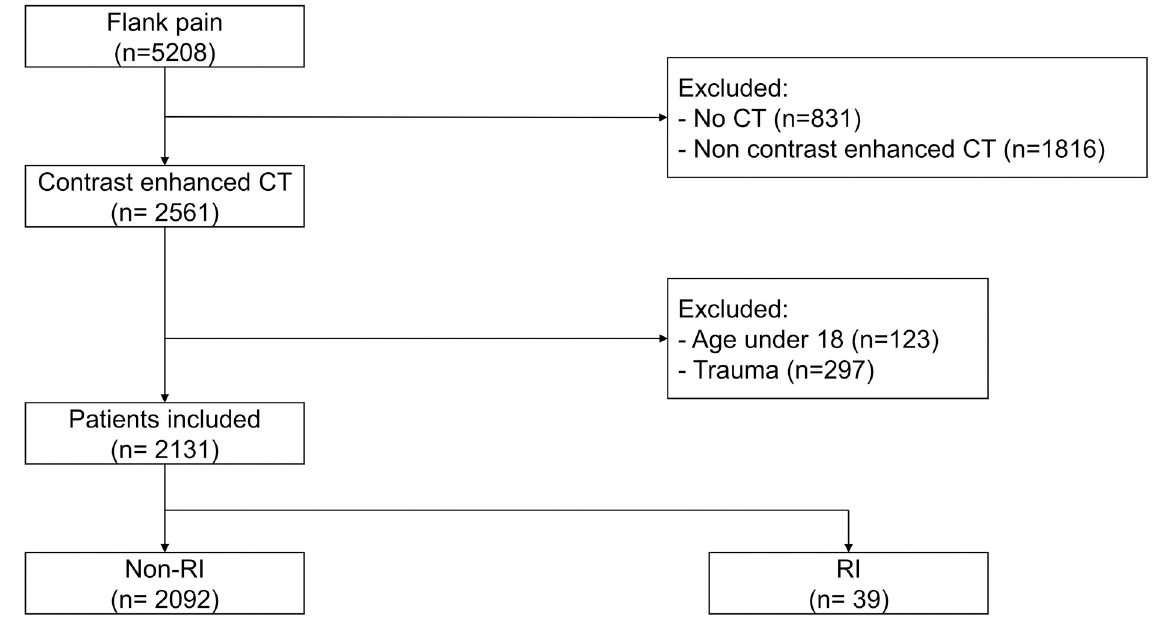
Fig 1. Flow chart of study subject enrollment. Abbreviations: CT, computed tomography; RI, renal infarction.